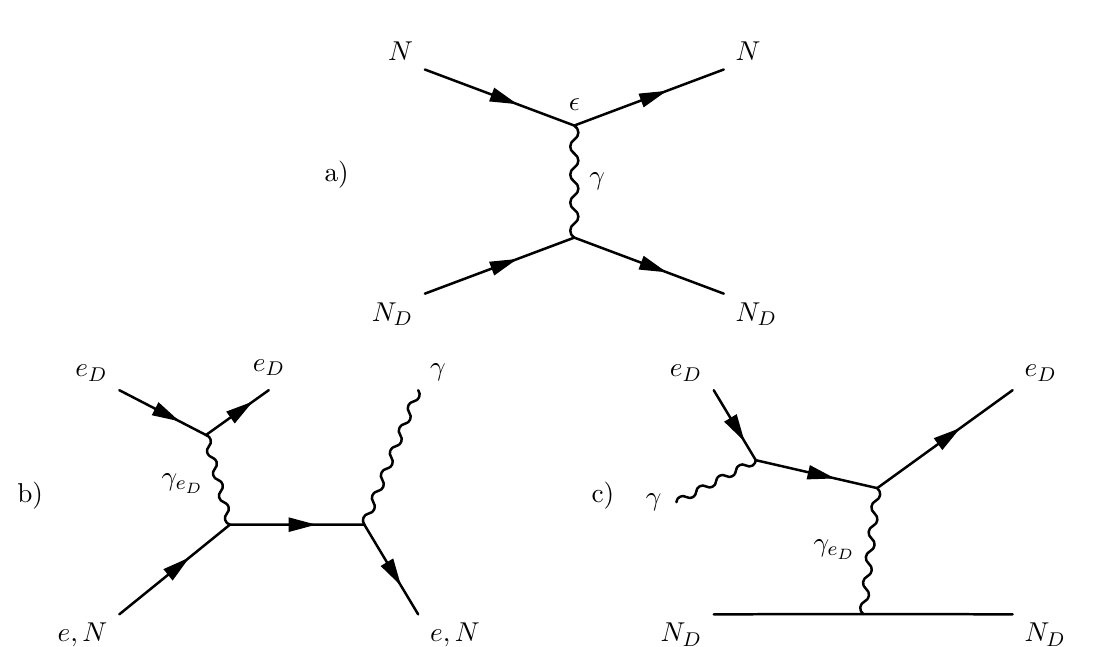
Figure 1 . The various important interactions between photons and matter / mirror matter: a) nucleus - mirror nucleus scattering, b) conversion of mirror photons to SM photons via Thomson- like scattering with SM matter, c) absorption of SM photons via free-free absorption, or inverse bremsstrahlung. (cid:13) e is de(cid:12)ned to be the state that couples to mirror matter. In the basis of (2.2), D j A (cid:22) i = j A (cid:22) i (cid:0) (cid:15) j A (cid:22) i . e D D